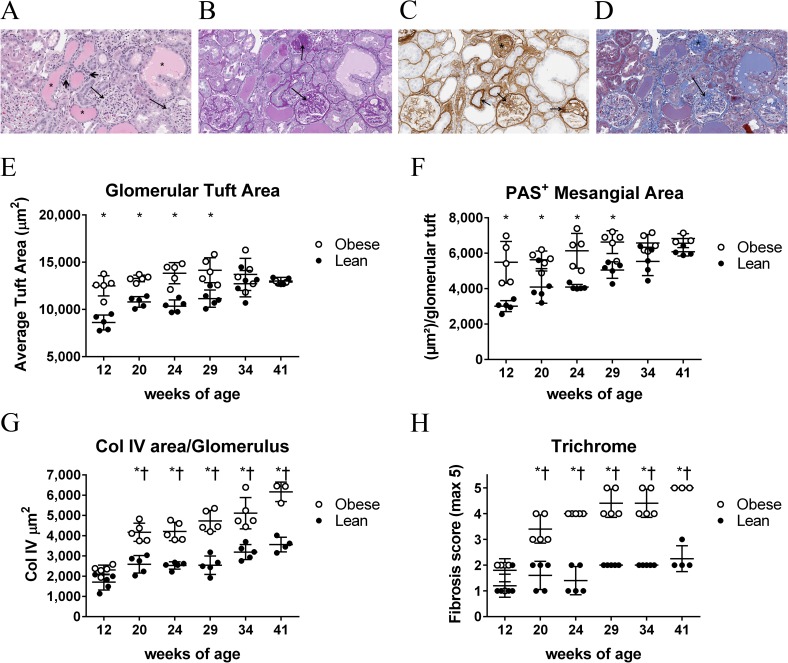
Obese ZSF1 have histologically evident renal fibrosis by 20 weeks of age that worsens over time.(A-D) Kidney section from a 34-week-old obese rat stained with (A) hematoxylin and eosin (H & E), (B) Periodic Acid Schiff (PAS), (C) Collagen IV (COL IV) IHC, or (D) trichrome. Highlighted features are as follows: (A) hyaline casts and proteinaceous material in dilated tubules (asterisk), thickened glomerular basement membranes (long arrows), and leukocytic infiltrates (short arrows); (B) thickened mesangial matrix (arrows); (C) increased deposition of collagen IV in glomerular mesangial matrix and basement membranes (asterisk and arrows); and (D) increased collagen in mesangial matrix (asterisk and arrows). (E) Glomerular tuft area as determined from H & E staining. (F) PAS positive glomerular mesangial area. (G) Results from Collagen IV immunohistochemistry expressed as Col IV staining area per glomerulus. (H) Results from blinded semi-quantitative trichrome staining for fibrosis severity.